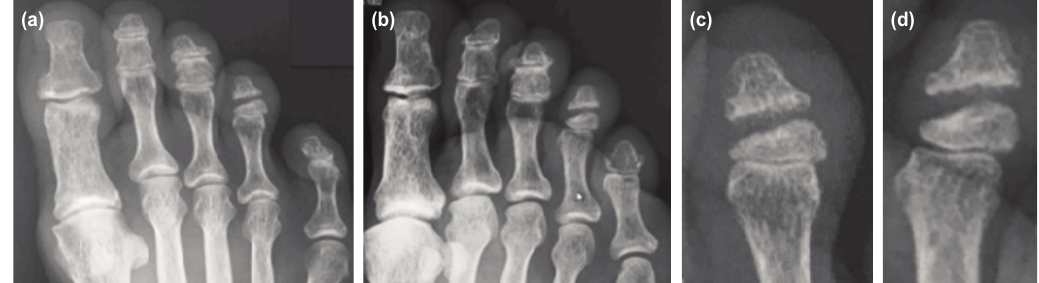
Pre-operative radiographs of fracture non-union of right fourth toe distal phalanx. (a) Dorso-plantar foot view, (b) Oblique foot Fig. 1: view, (c) Magnified dorso-plantar fourth toe view, (d) Magnified oblique fourth toe view.